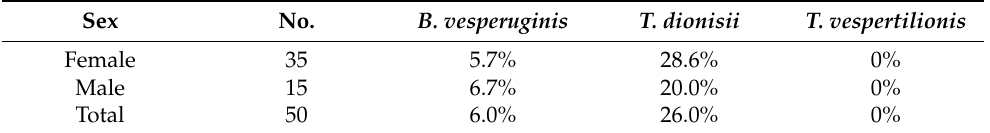
Table 2. Total blood smear-based prevalence of blood parasites and prevalence in males and